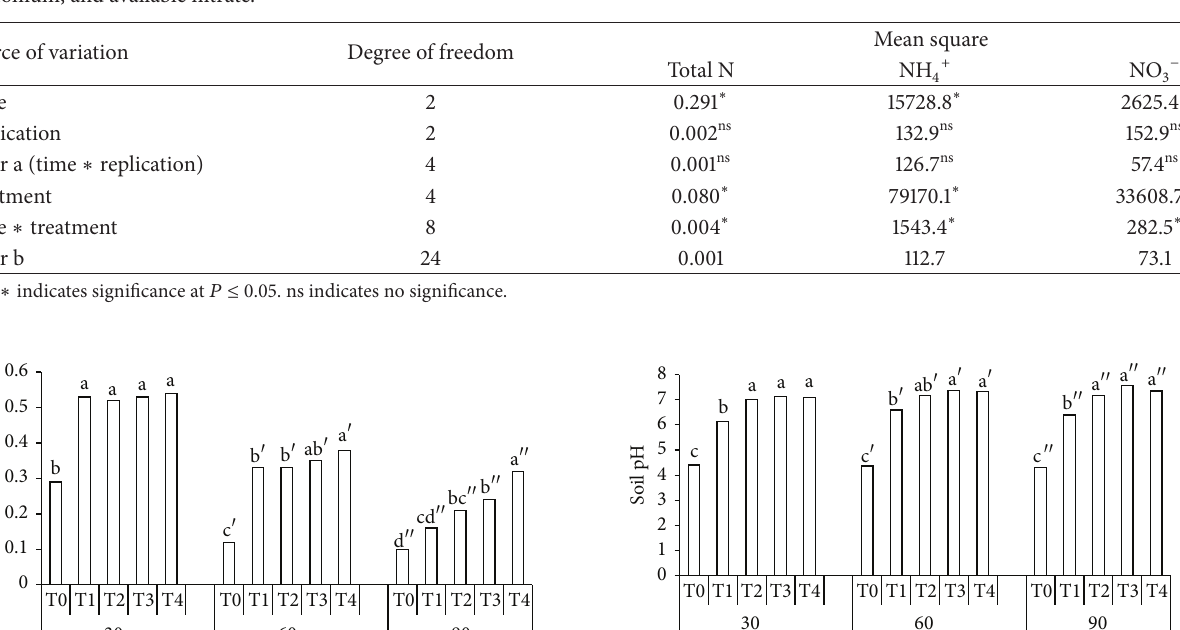
Table 5: Significant levels from analysis of variance (ANOVA) to determine the effects of treatments and time on total N, soil exchangeable ammonium, and available nitrate.